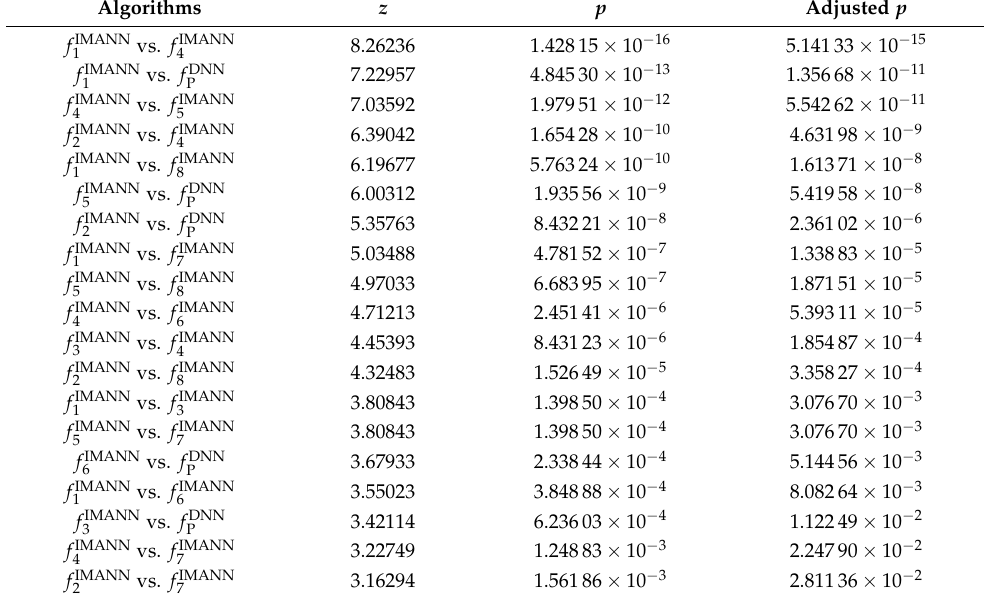
Table 3. Shaffer Table for α =